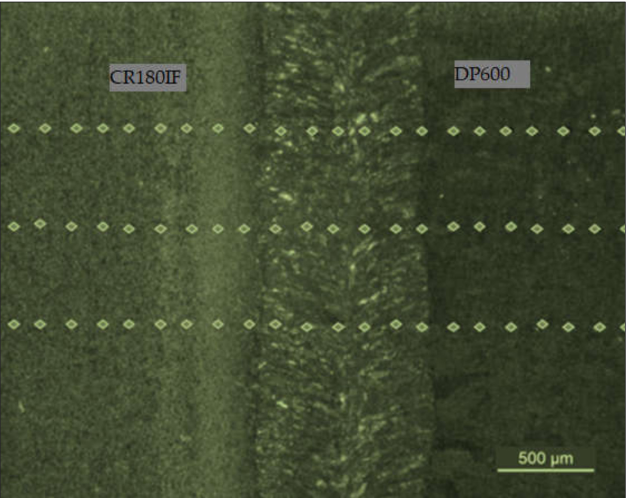
Figure 1. The indentation lines after surface microhardness HV0.1